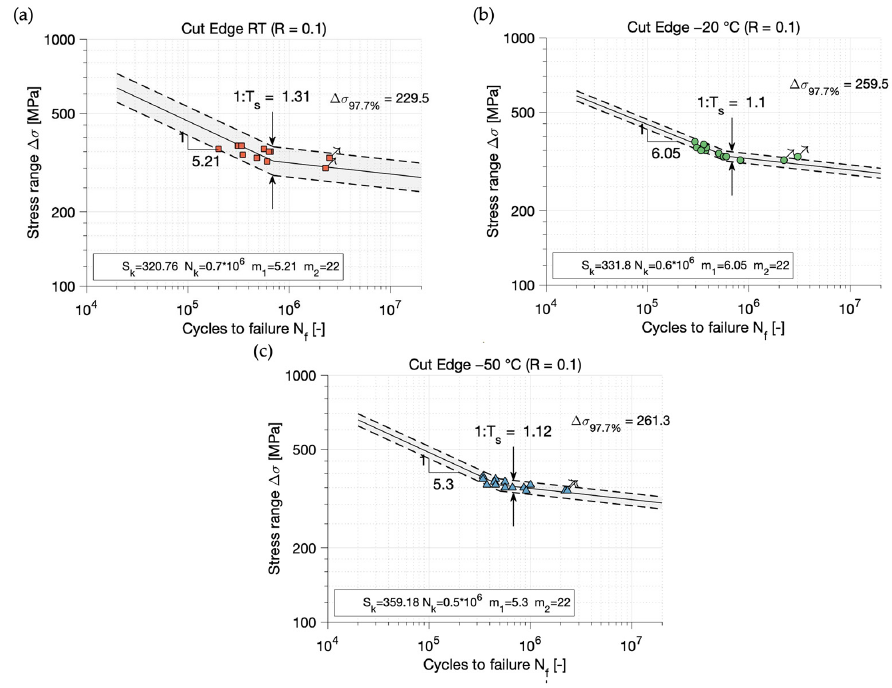
Figure 6. S-N curves of AH36 cut edges from maximum likelihood method for RT ( a ), − 20 °C ( b ) and − 50 °C ( c ).